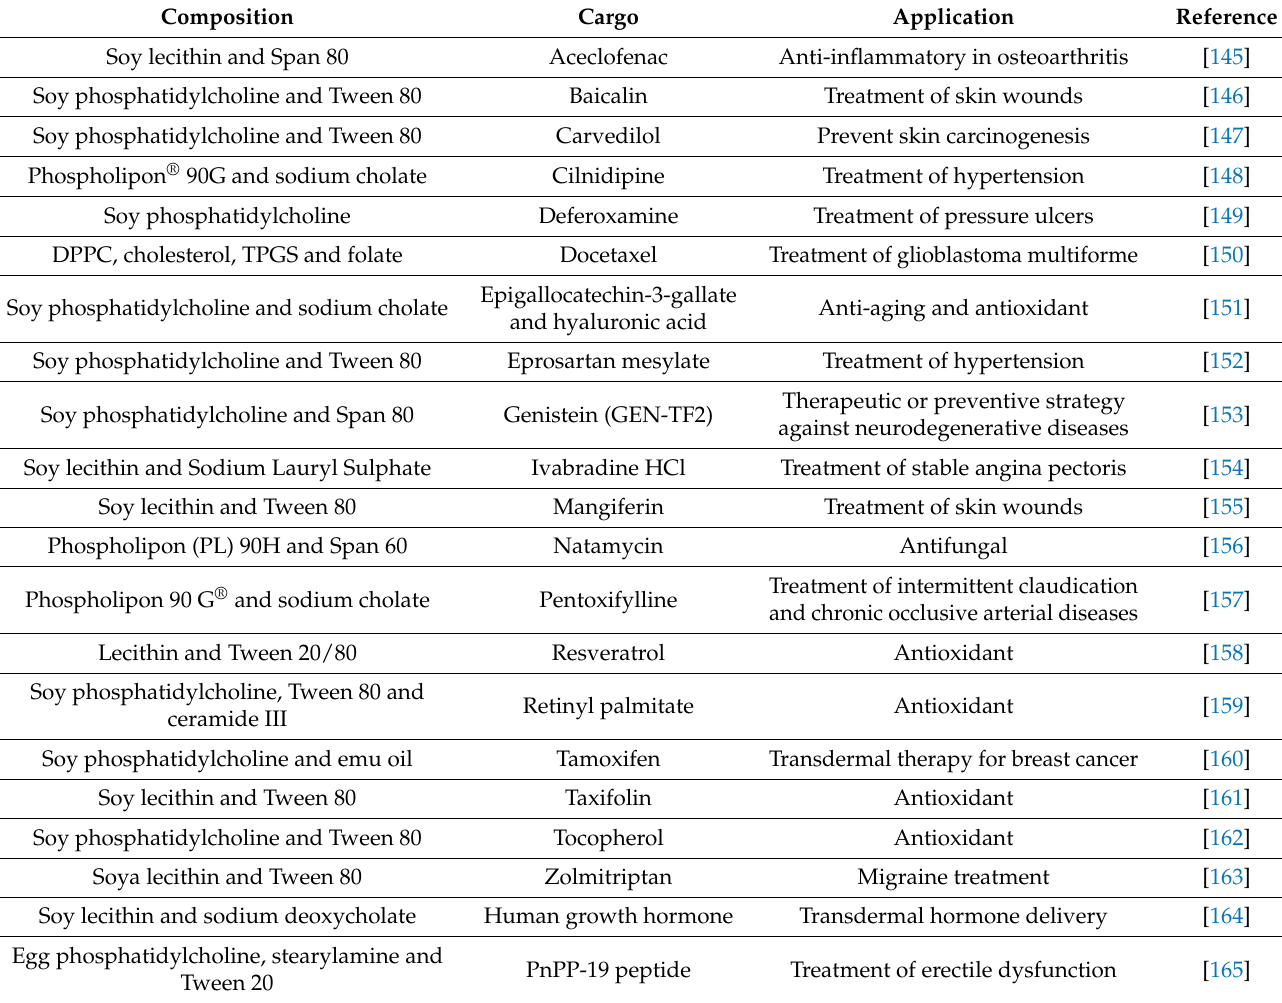
Table 4. Transfersomes’ drug delivery